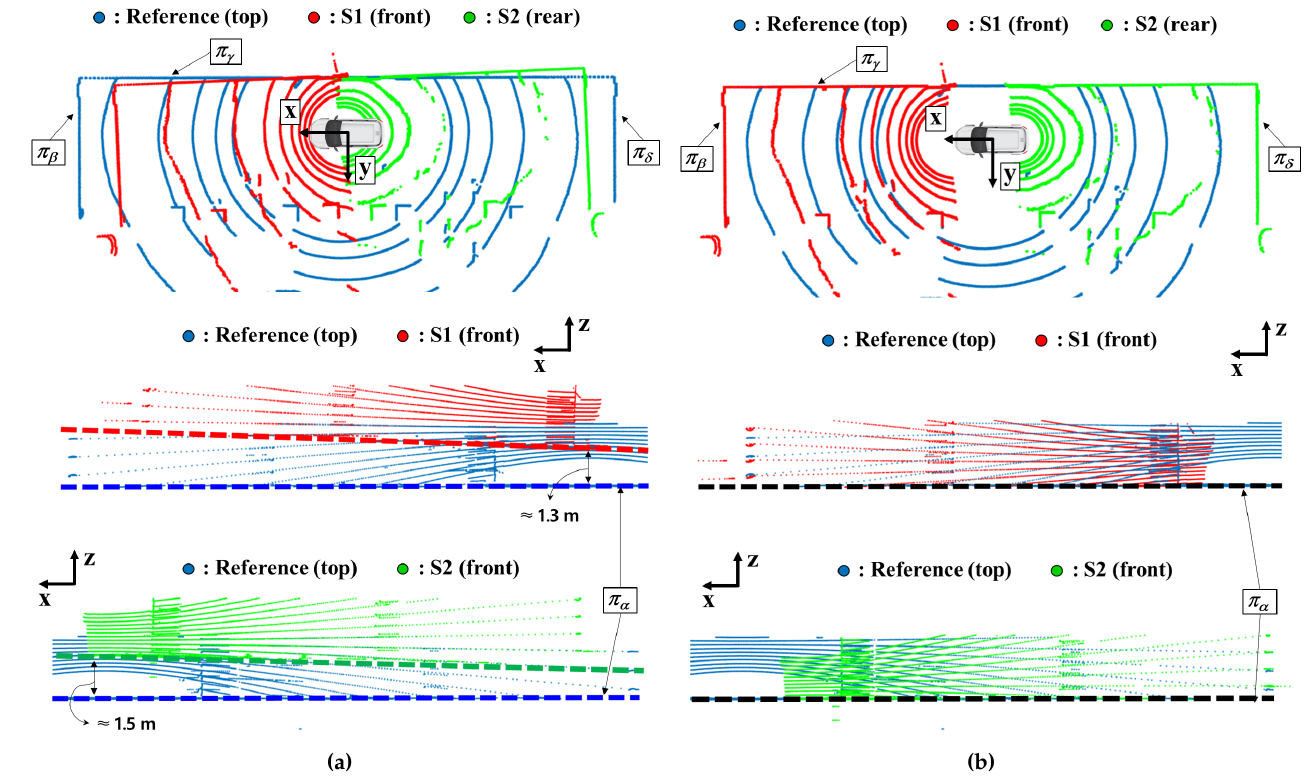
Figure 8. Point clouds from the reference (blue dots), front (red dots), and rear (green dots) LiDAR sensors of the vehicular system. ( a ) the point clouds before calibration. ( b ) the point clouds after cali- bration. Each row of the figures corresponds to the top view ( upper ), side view of the front ( middle ), and side view of the rear ( lower ), respectively. The dashed lines in the side views correspond to the ground